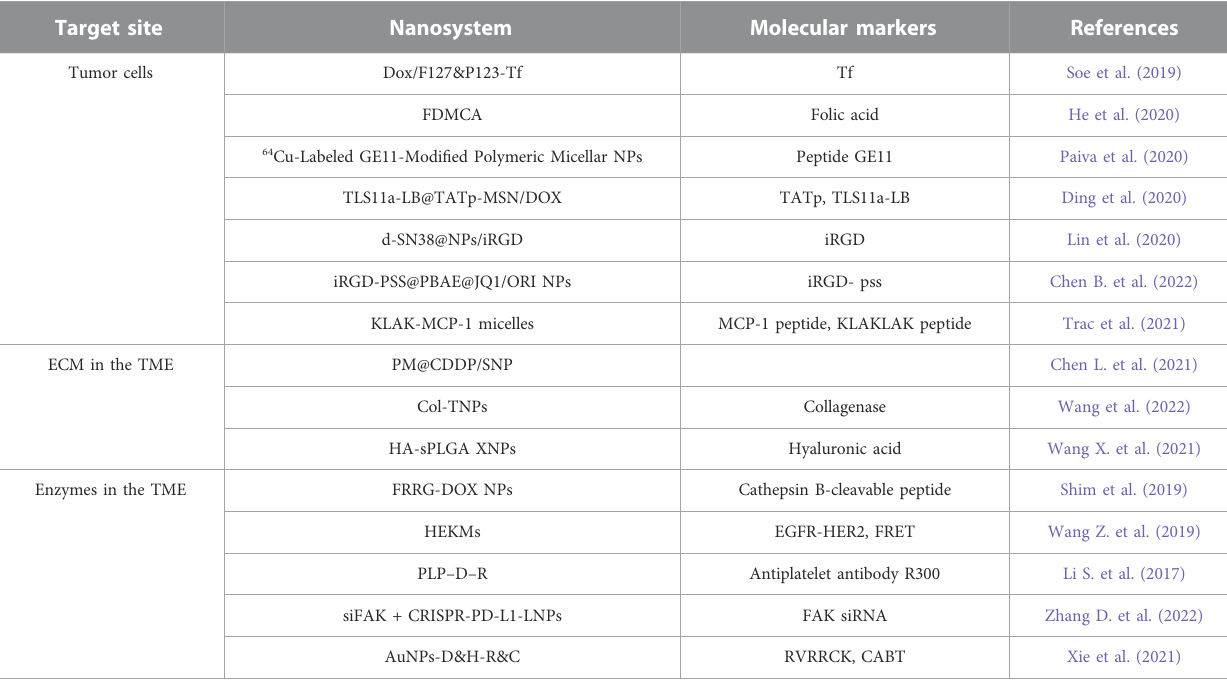
TABLE 2 Nanoparticles designed for different components of the tumor